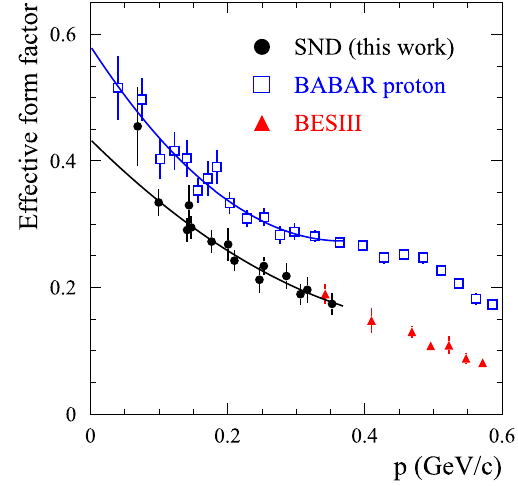
Fig. 15 The neutron effective form factor as a function of neutron momentum obtained in this work compared with the BESIII measure- ments [3], and the proton effective form factor measured by BABAR [16]. The combined statistical and systematic uncertainties are shown forallthreedatasets.Thecurvesrepresentresultsofthefittotheneutron and proton form factor data with a second order polynomial